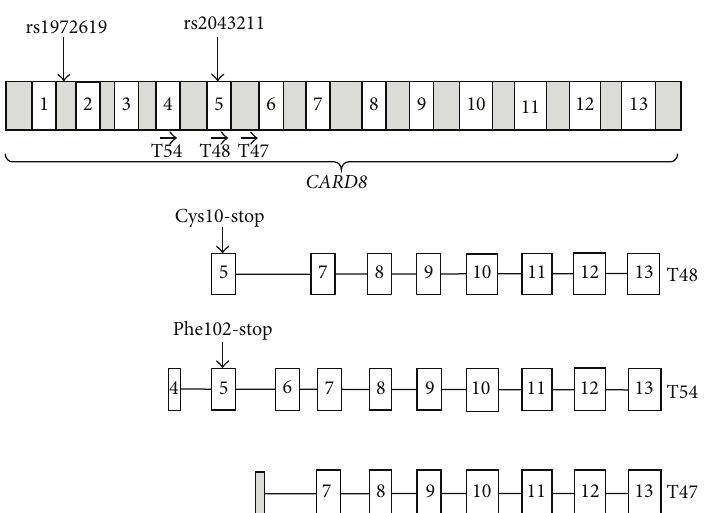
Figure 2: Schematic representation of polymorphism in the CARD8 gene and mRNA isoforms (modified from Bagnall et al. 2008 [45]; not to scale). Exons of the CARD8 gene are displayed as white boxes. The arrow ( → ) represents the site of open reading frame (ORF) for the given